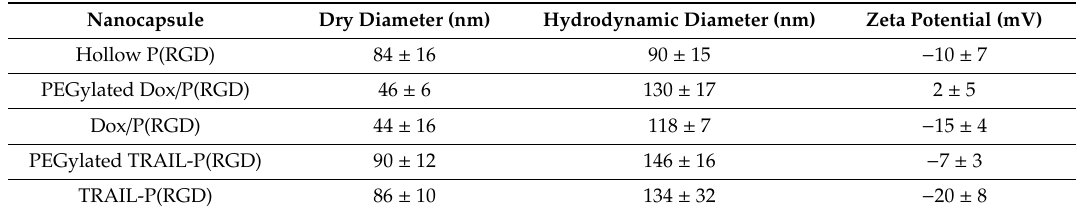
Table 1. Dry and hydrodynamic diameters (nm) of hollow, Dox-loaded and TRAIL-conjugated P(RGD) NCs analyzed by ImageJ software and DLS.